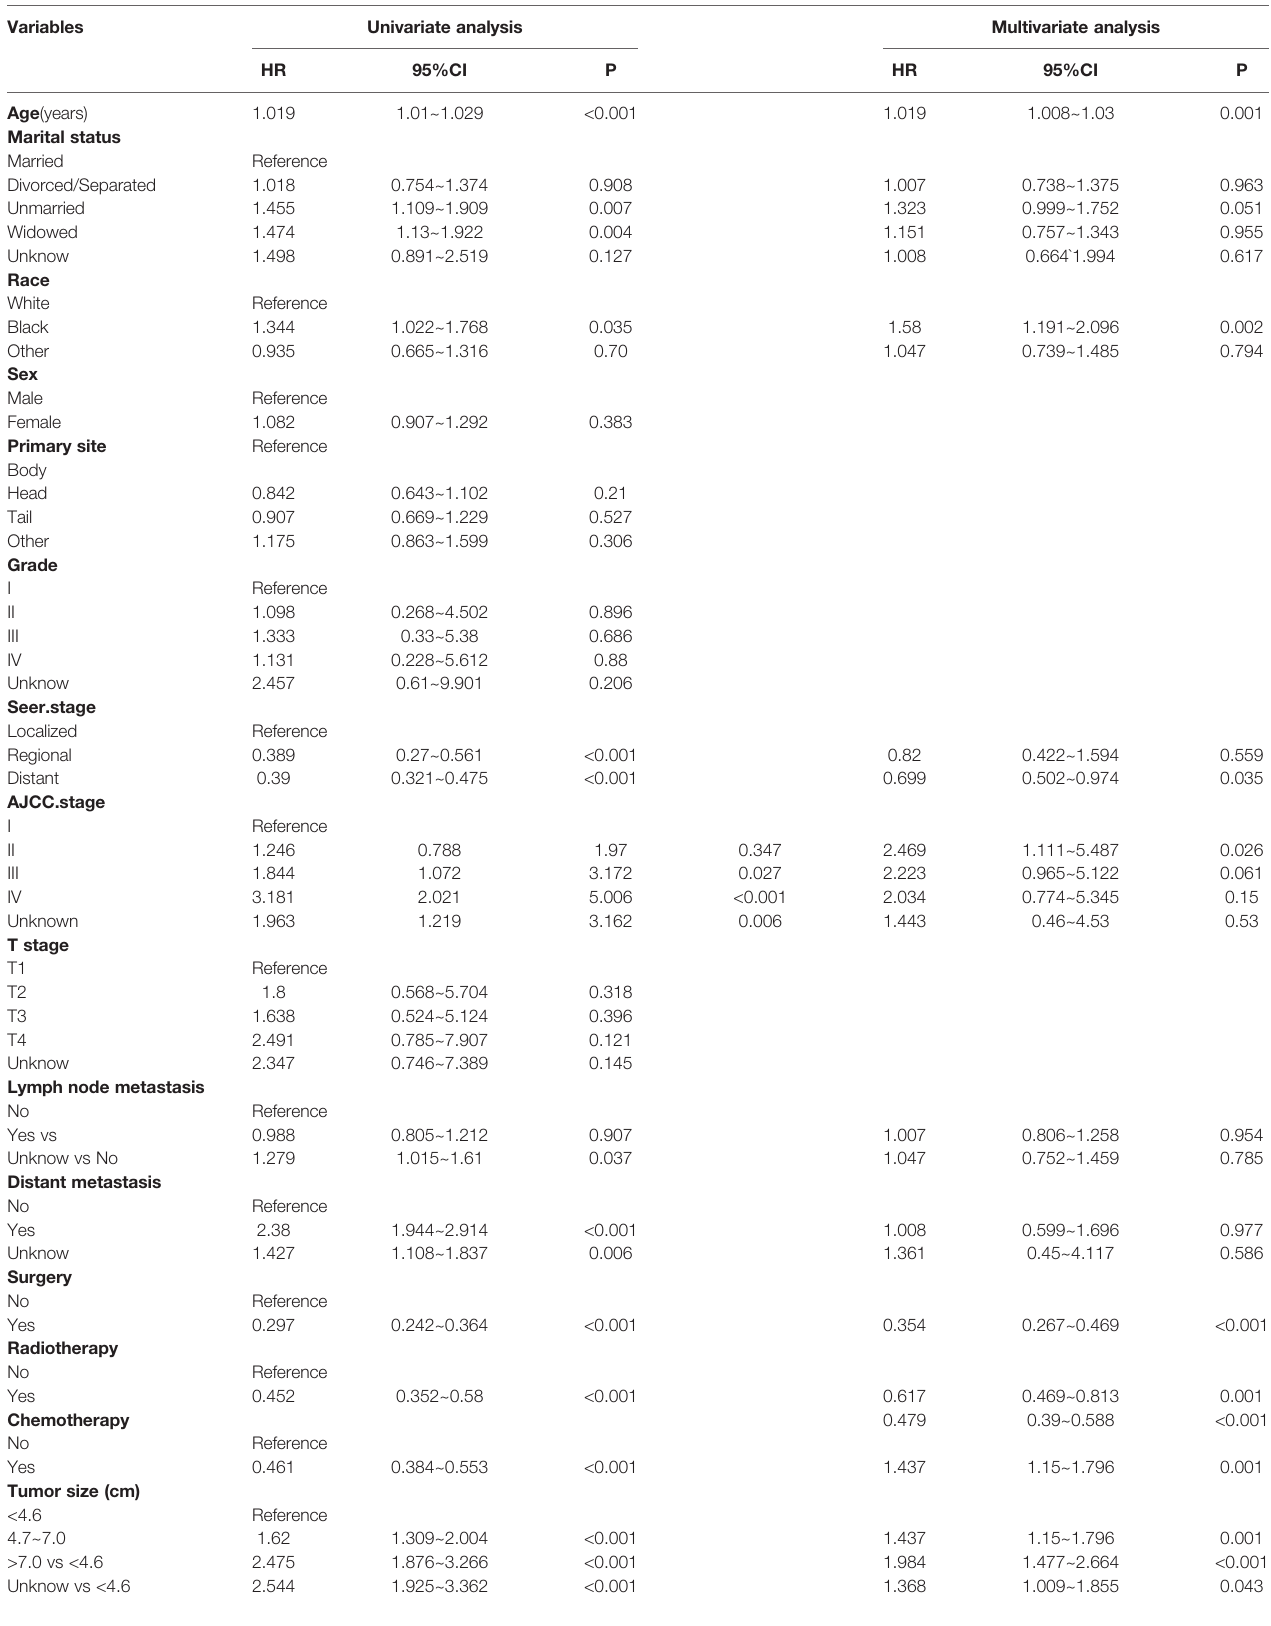
TABLE 2 | Univariate and multivariate cox regression analyses of the prognoses of the